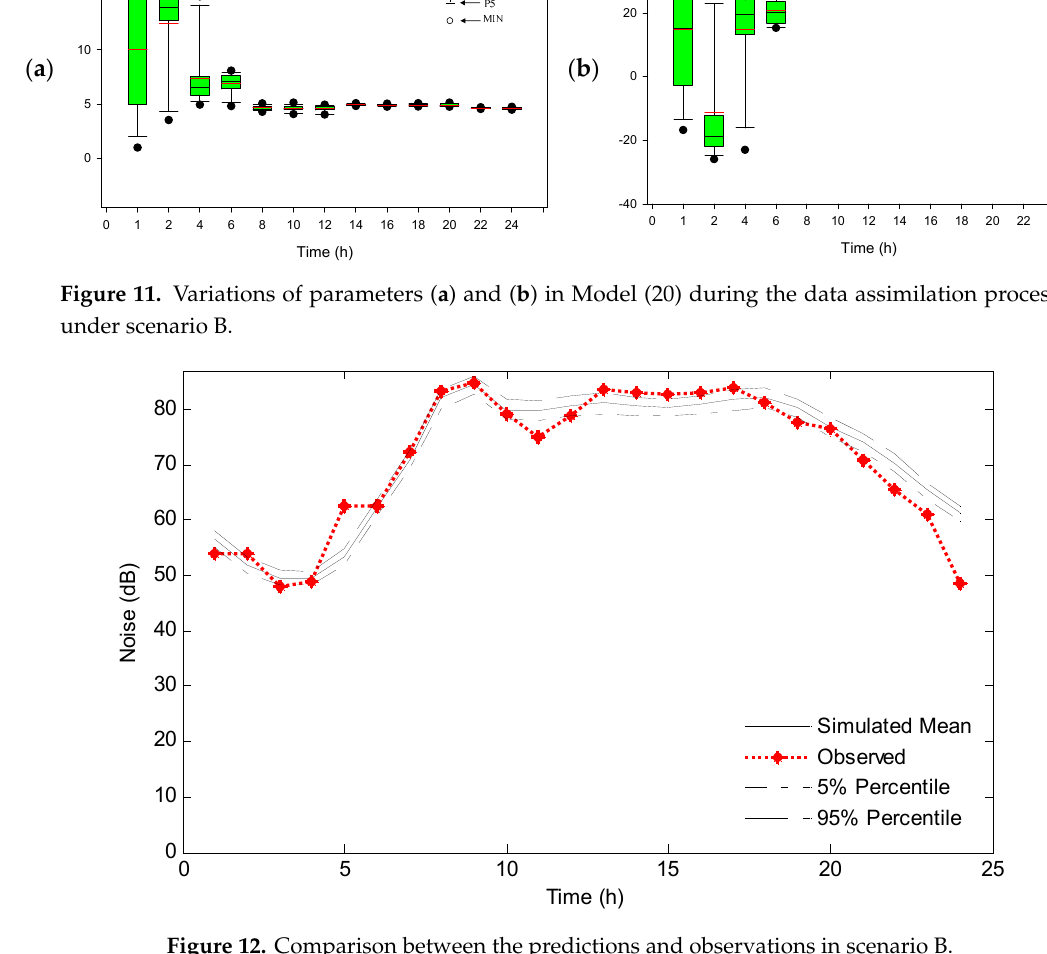
Figure 12. Comparison between the predictions and observations in scenario B.